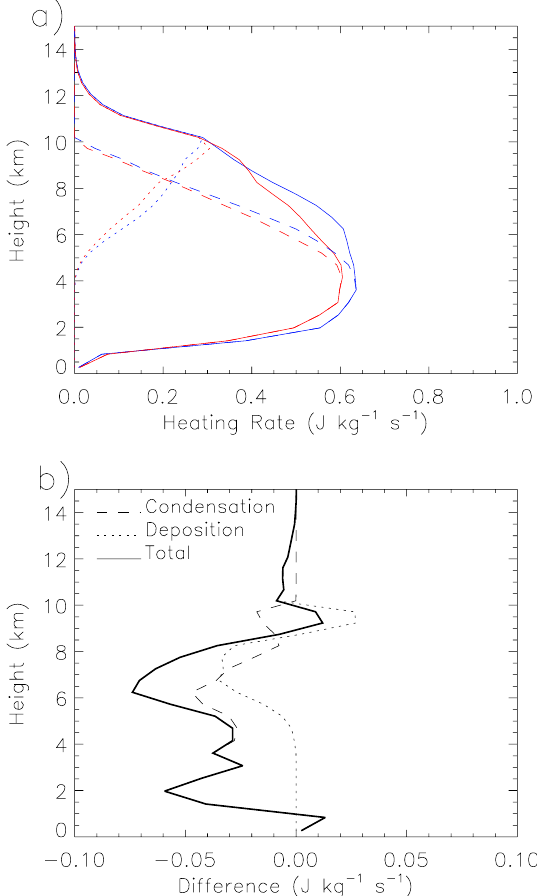
Fig. 11. (a) Vertical profiles of domain-mean latent heating con- tributions from cloud water condensation (dash), freezing of cloud liquid water and rain (dot-dash), vapor deposition onto ice (dotted), and the total latent heating (solid) for the BASE configuration at t = 120min. Results for pristine (PRIS) and polluted (POLL) con- ditions are indicated by blue and red lines, respectively. (b) Differ- ence in the latent heating contributions (POLL minus PRIS).